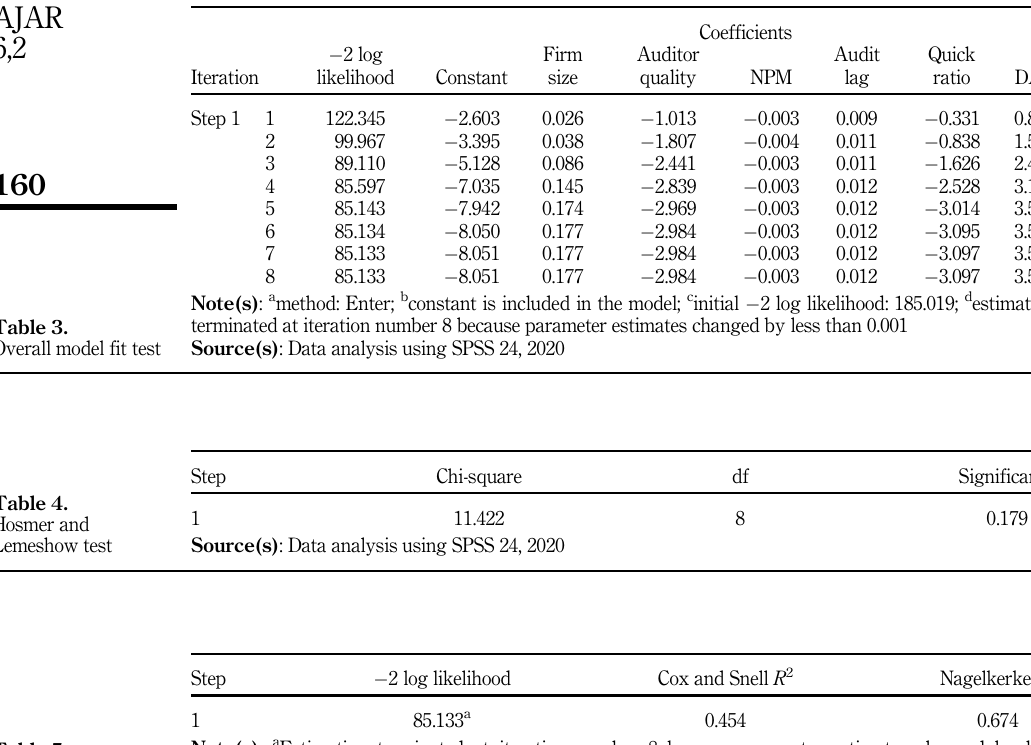
Table 5. Determinant